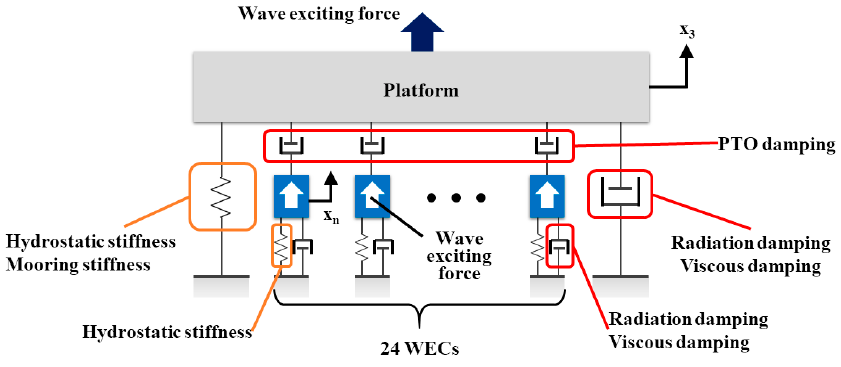
Figure 5. Schematic model of platform and